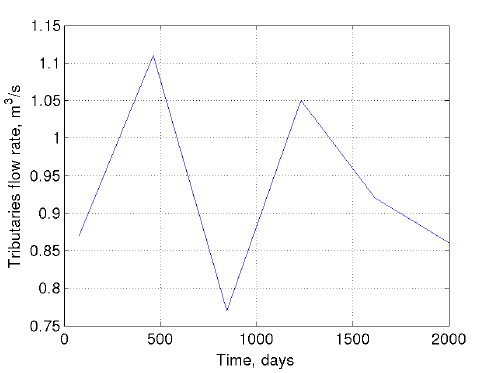
Figure 8. Average of the maximum values of flow rates for each year (from 2002 to 2007) depicted when time is shown in